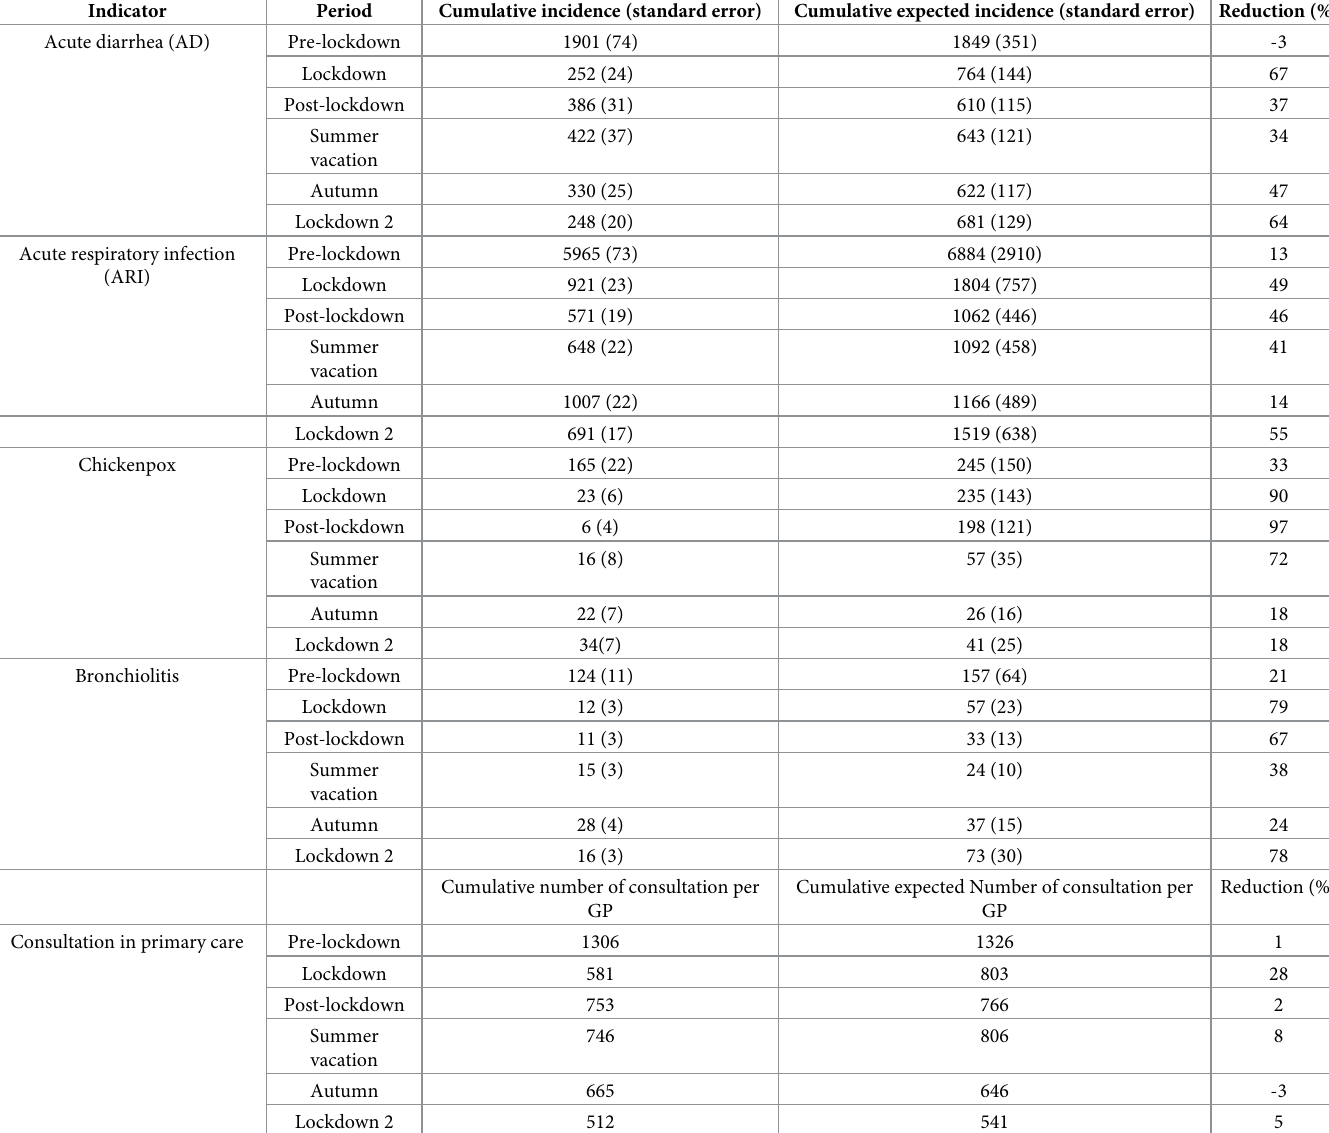
Table 2. Difference between observed and expected cumulative incidence and number of GP’s consultation in France